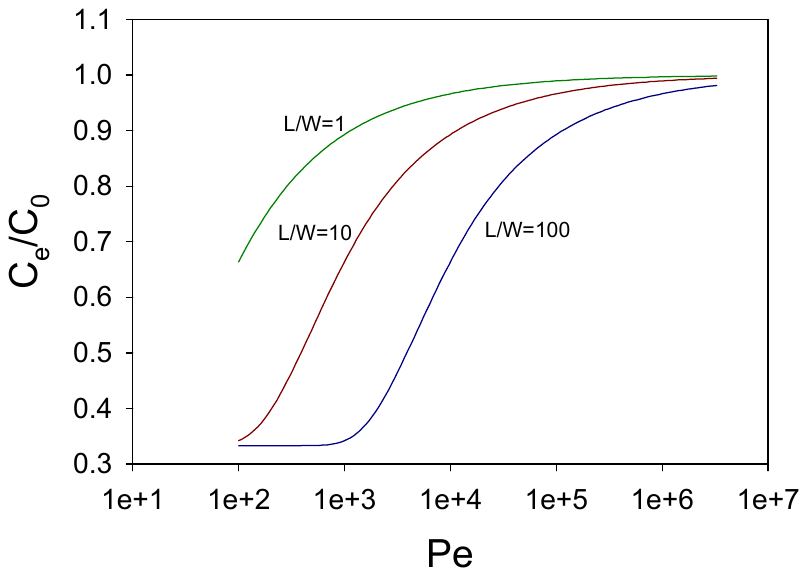
Fig. 4. Semi-log plot of dimensionless concentration ratio (outlet/inlet) as a function of Péclet number (Pe = UW/D ) at different L/W m